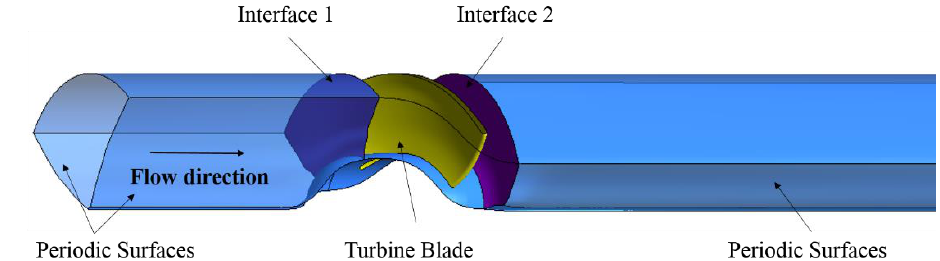
Figure 3. Computational domains.